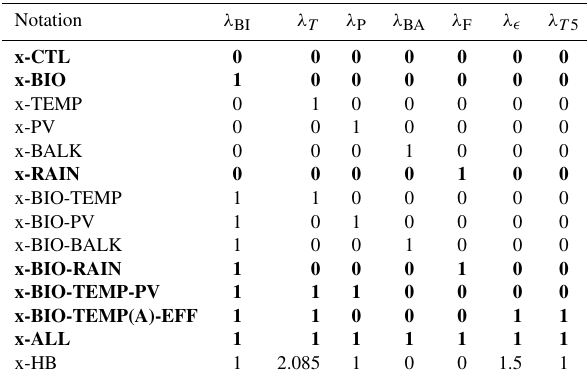
Table 2. Overview of the cases considered and their notation. The left column displays the used feedback. The other columns show the notation and what feedbacks are included in the specific case. The “x” in the notation is replaced with either P for the PI configuration or L for the LGM configuration. Bold rows indicate that this combi- nation of feedbacks is also used for cases with a coupling between the AMOC and atmospheric p CO 2 (Sect. 3.2). For these cases, “ C ” is added to either “ P ” or “ L = ” to denote the coupling. The last col- umn represents the feedback combinations used in Sect. 3.3. Case x-CTL is the original SCP-M.